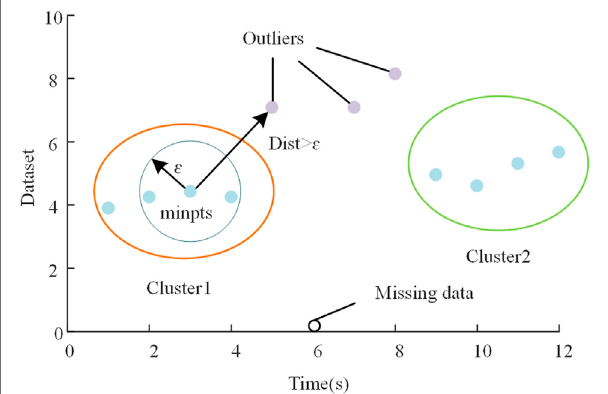
FIGURE 3 | The process of DBSCAN